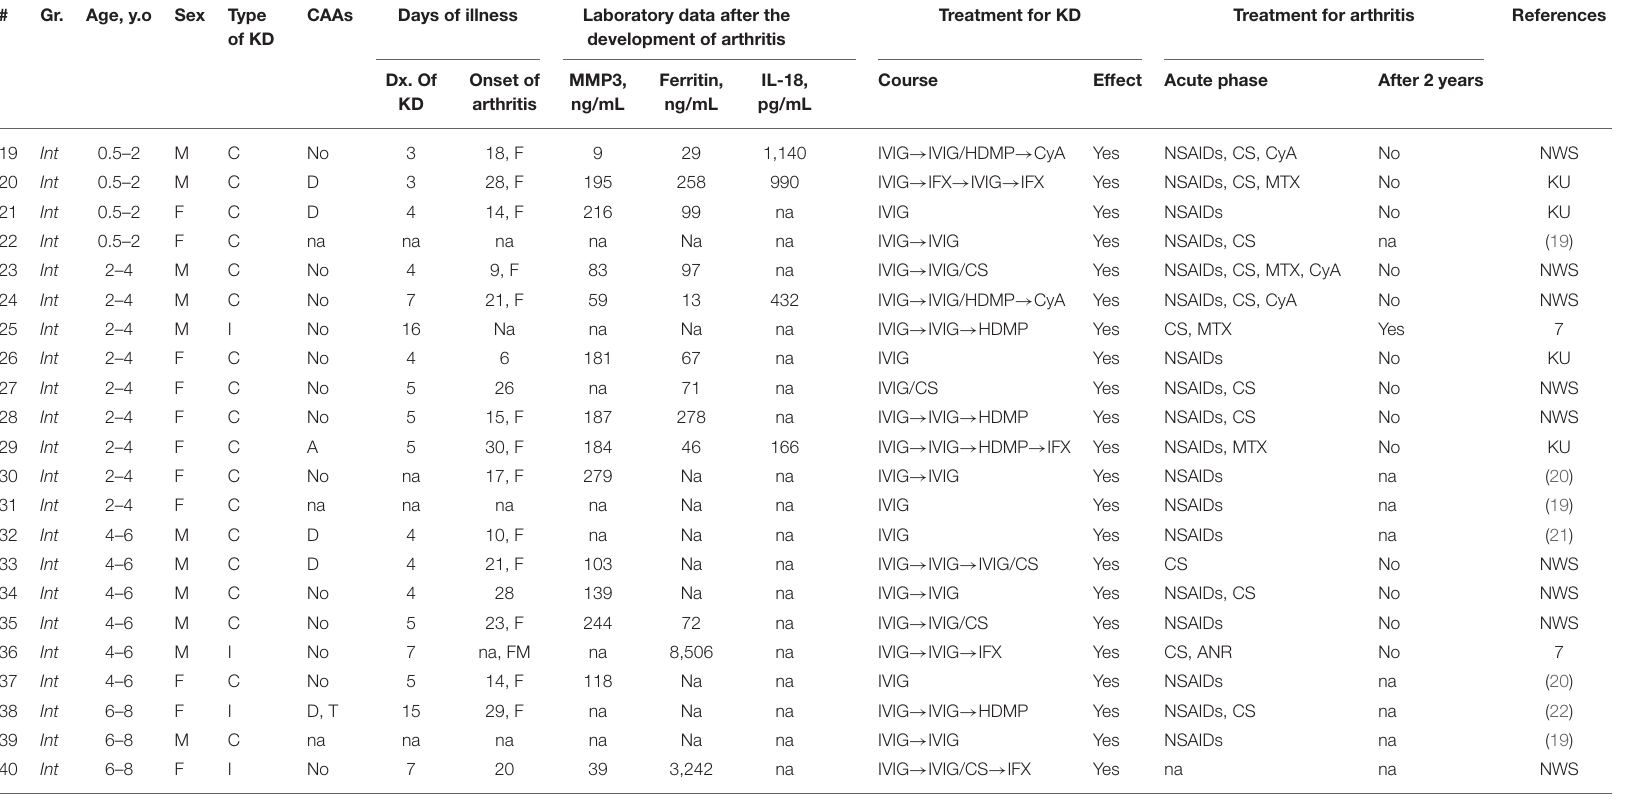
TABLE 3 | Detailed information of the interval fever-onset ( Int. )